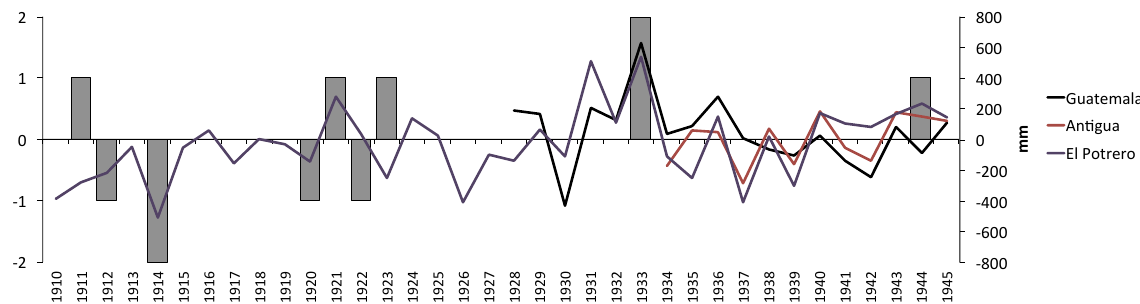
Figure 6. Semi-quantitative hydrological index reconstructed in this study (1910–1945) and annual precipitation anomalies (calculated with respect to the average precipitation for the 1934–1945 period) for the meteorological stations of Antigua Guatemala, Guatemala City and El